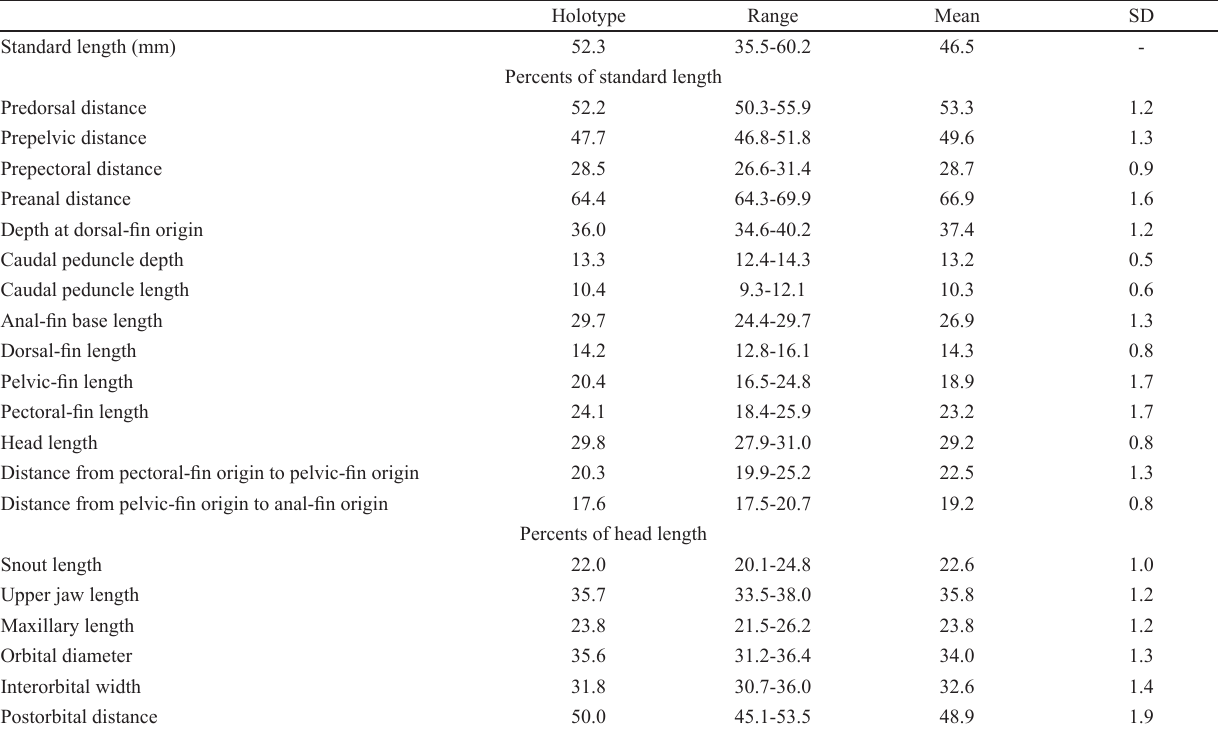
Tab. 1. Morphometric data for holotype and paratypes of Astyanax powelli , n = 41 (including holotype) from Río Sucuma basin, Catamarca, Argentina. SD = standard